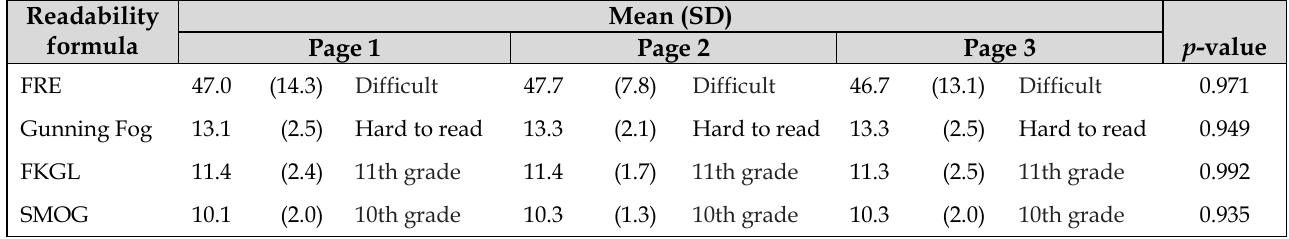
Table 3 Readability scores of websites according to their search results page